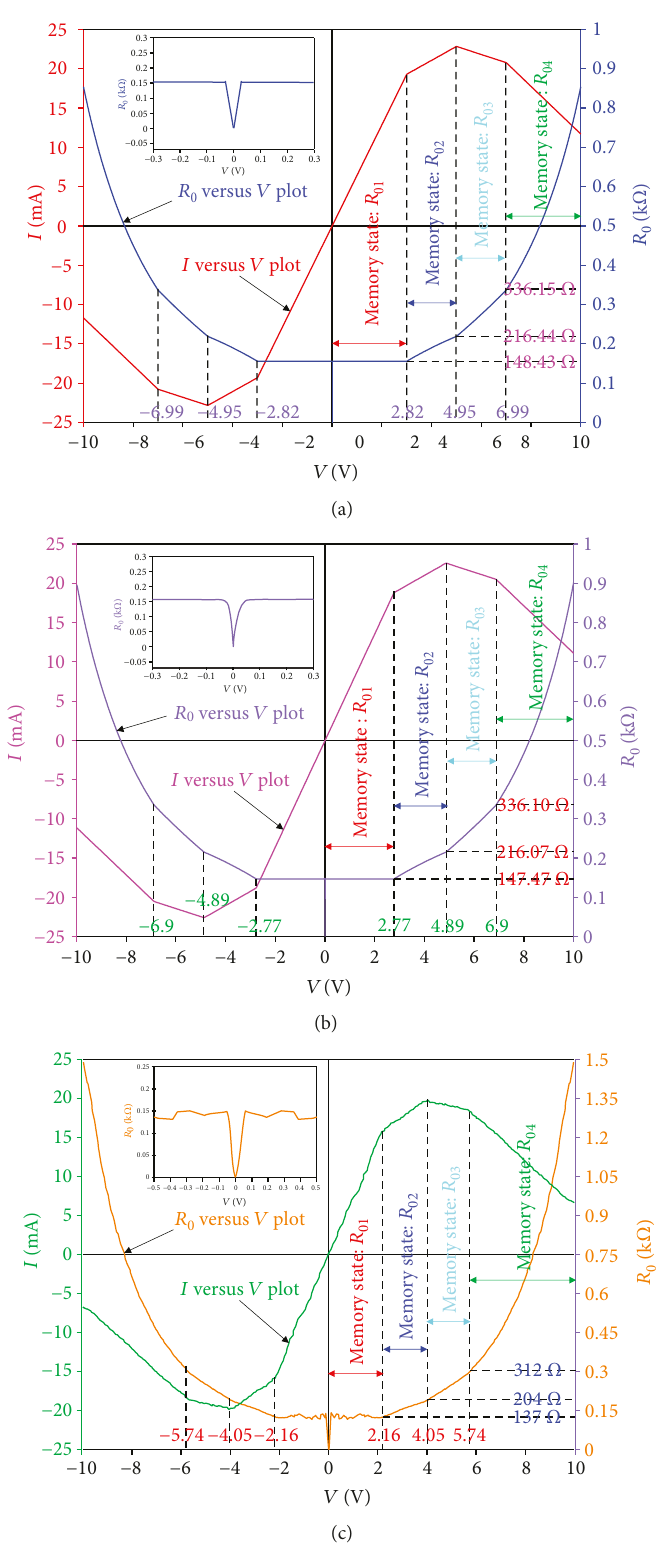
Figure 14: DC current I versus DC voltage V and DC resistance R versus V plot of mathematical model, (b) I versus V and R emulator. (a) I versus V and R 0 versus V plot of the actual circuit (c) I versus V and R 0